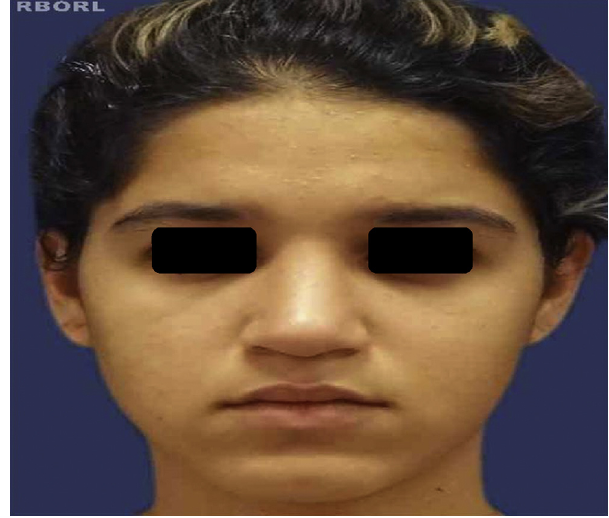
Figure 1 Preoperative frontal picture.